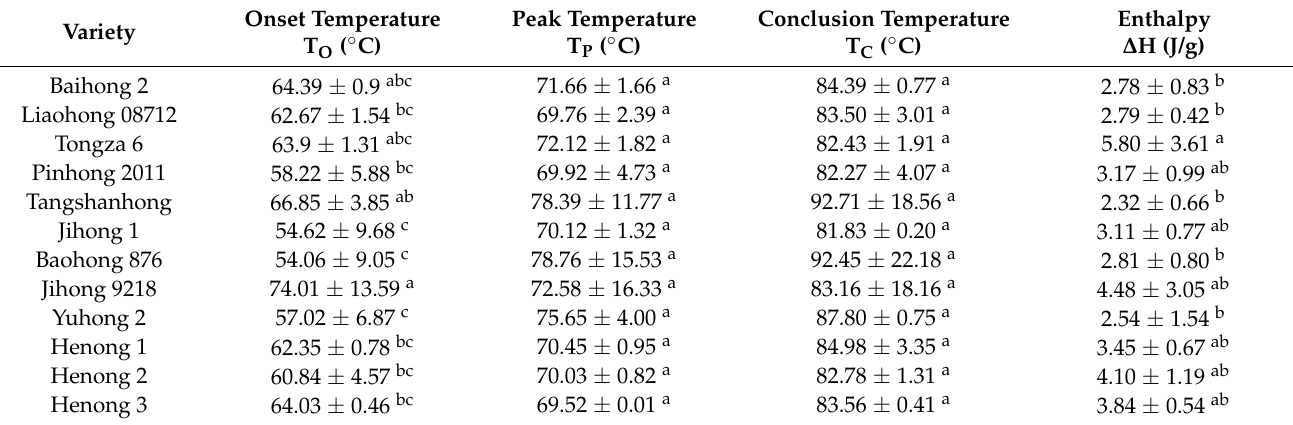
Table 3. Determination of thermodynamic properties of starch from different adzuki bean